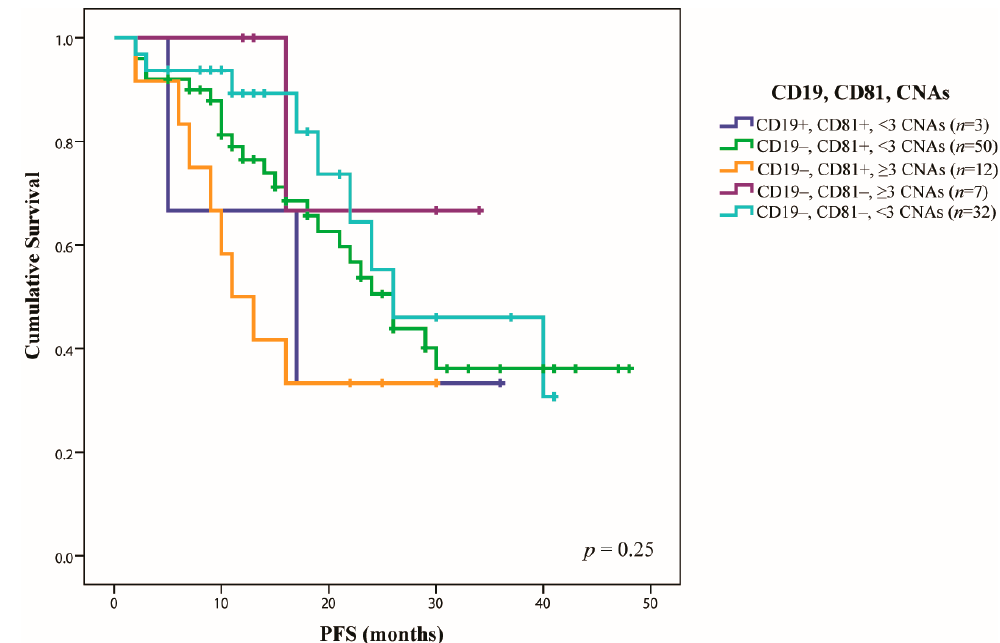
Figure A7. Survival by Kaplan–Meier analysis of association between CD19–CD81 and at least three adverse DNA damages (PFS). From the analysis we excluded the group CD19(+), CD81(+), ≥ 3 adverse CNAs, being represented be only one patient.